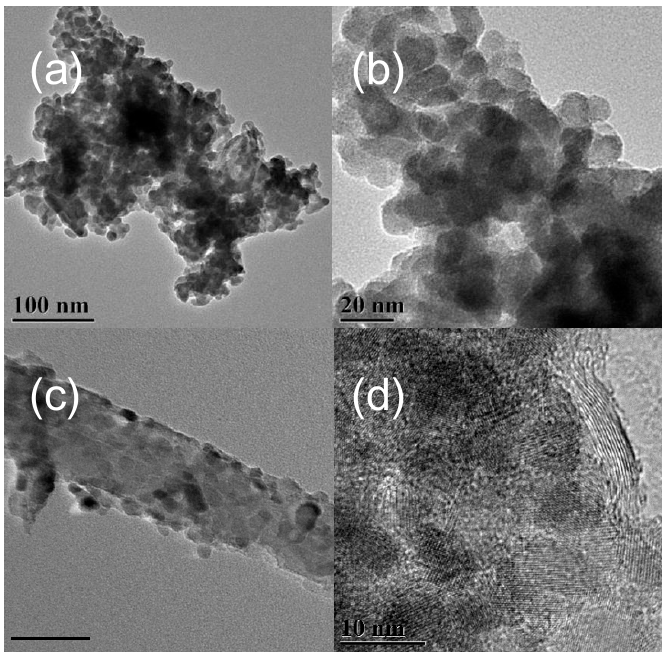
Figure 4. Transmission electron microscope (TEM) images of the Mo–Bi BMC-200 °C ( a , b ) and Mo–Bi BMC@CNTs-15% ( c , d ) nanocomposites.